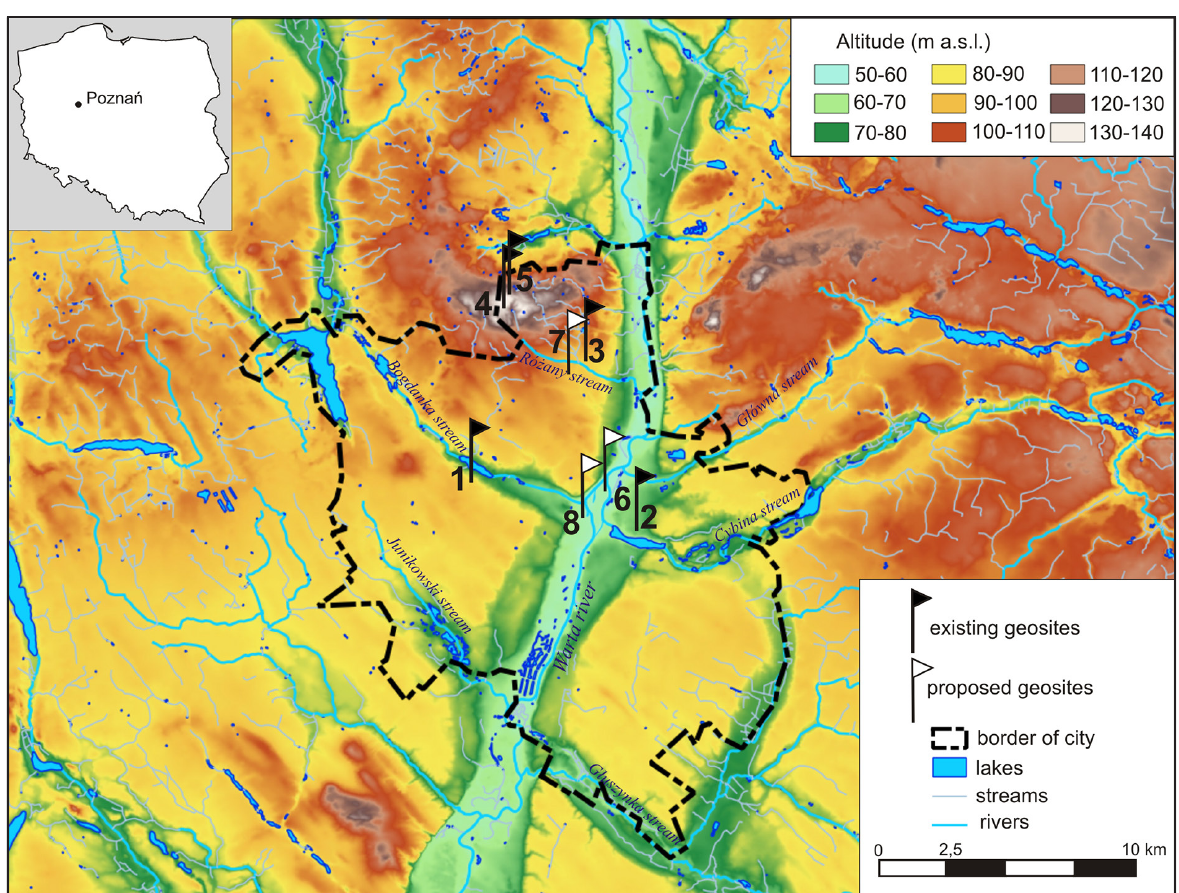
Fig. 1. digital elevation model and main elements of hydrographic network for Poznań vicinity (dEM elaborated on the basis of Vmap level 2 by J. Jasiewicz) with existing and proposed geosites. 1 – lapidarium in the Botanical Garden, 2 – lapidarium in the Millennium Park, 3 – lapidarium at the Institute of Geology, 4 – Morasko Hill, 5 – Impact Crater Morasko, 6 – Genius Loci , 7 – Żurawiniec peat bog, 8 – Poznań section of the Warta River